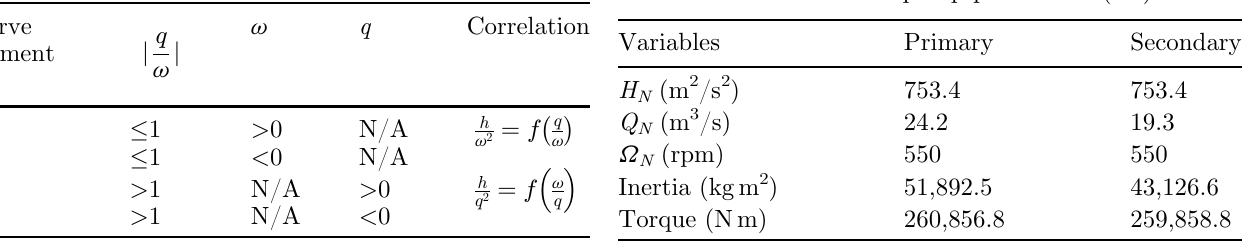
Fig. 5. Homologous pump – torque curves. Table 3. Characteristics pump parameters (1D).